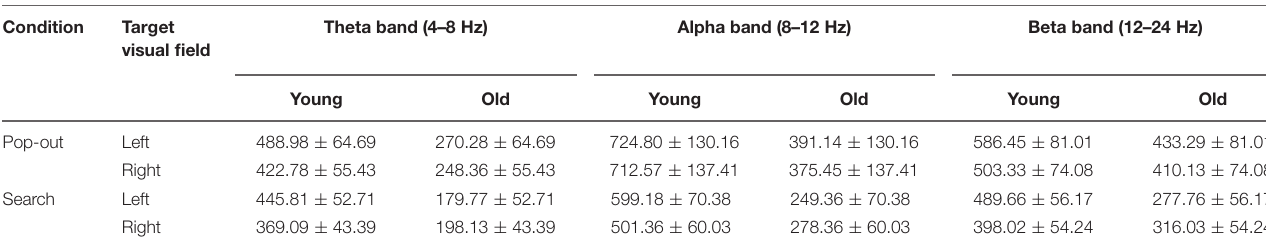
TABLE 2 | The total coupling values for all pair-wise combinations of electrodes in the theta, alpha, and beta frequency bands (mean ± SEM).